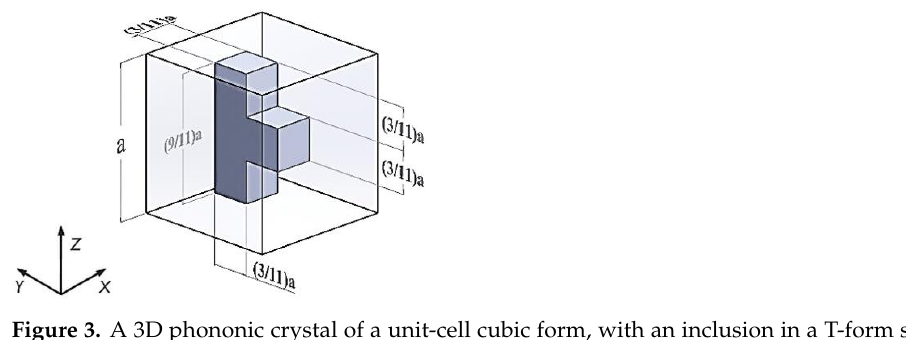
Figure 3. A 3D phononic crystal of a unit-cell cubic form, with an inclusion in a T-form shown in square